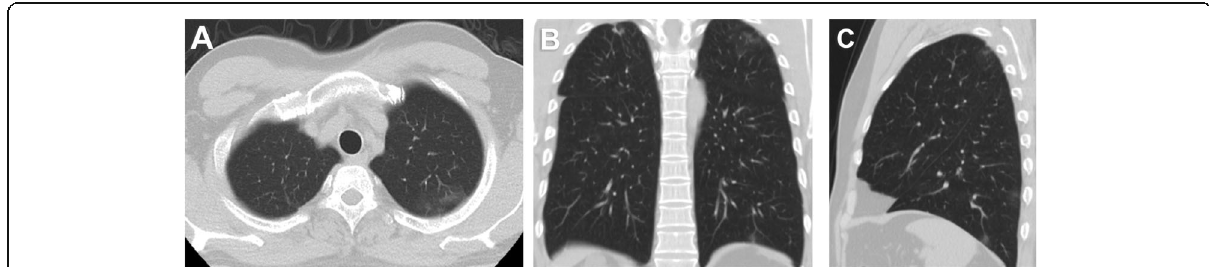
Fig. 6 A 53-year-old female patient. A axial, B coronal, and C sagittal chest CT images show bilateral peripheral small ground-glass opacities with minimal pulmonary involvement (< 5%) corresponds to current chest CT score 4 and a simple chest CT score 1 (minimal affection). The patient survived